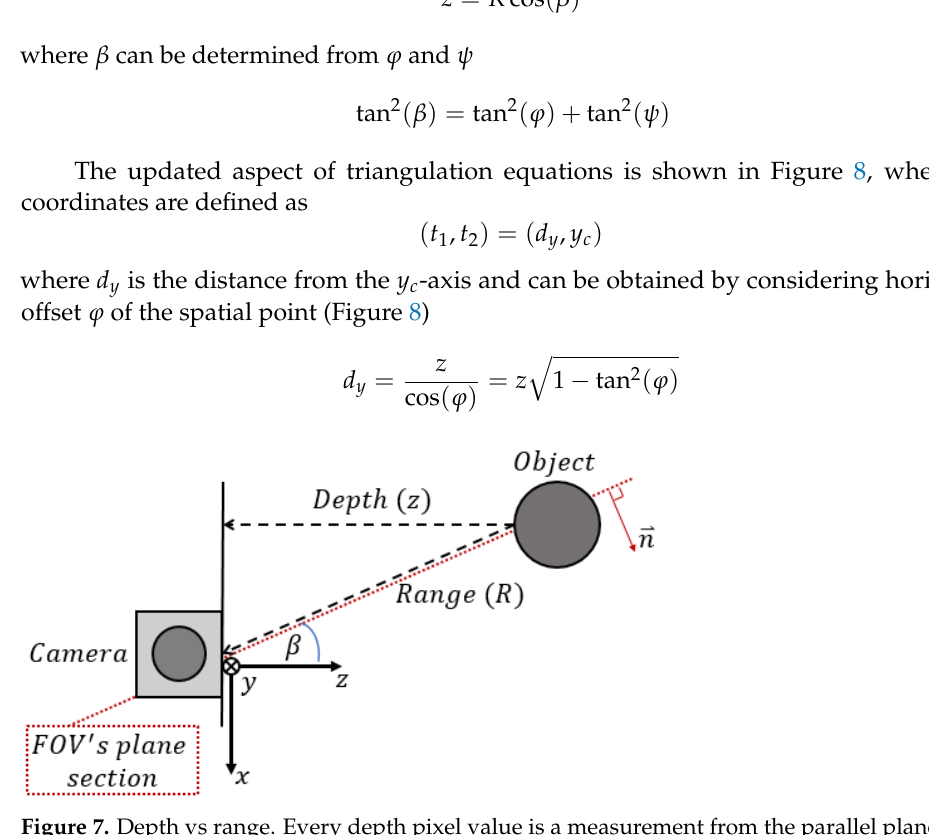
Figure 7. Depth vs range. Every depth pixel value is a measurement from the parallel plane of the imaging devices (i.e., a pair of cameras) and not the absolute range to the